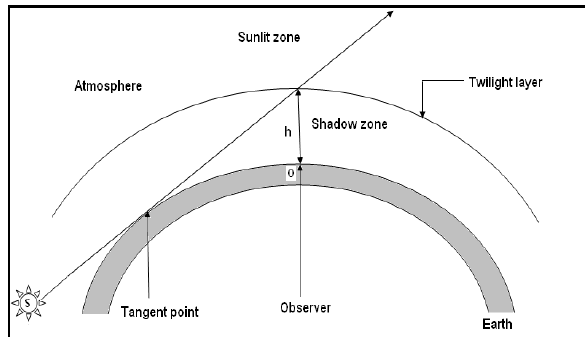
Figure 1: Schematic diagram of twilight